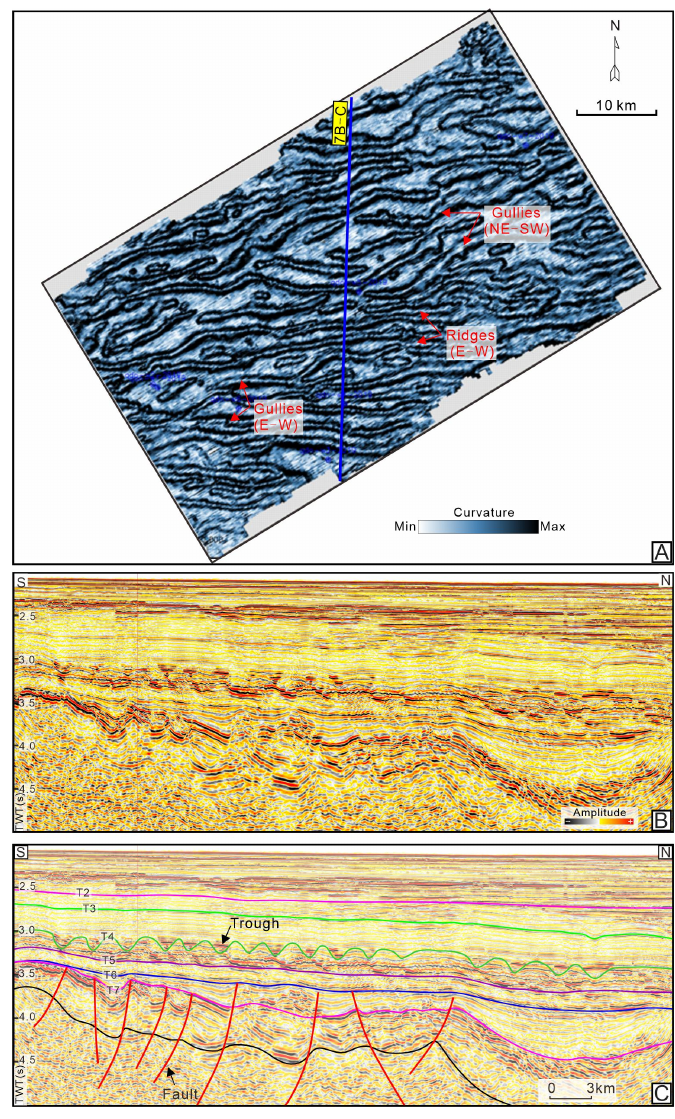
Figure 7. ( A ) Characteristics of mounded topography revealed by curvature analysis based on 3D seismic data (See Figure 6 for the location of the 3D survey). The mounded topography is characterized by the alternating distribution of nearly EW-trending elongate troughs and ridges. ( B , C ) The top of the Miocene Meishan Formation has a mounded topography characterized by the mounds alternating with troughs (for location, see Figure 7A). TWT = two-way